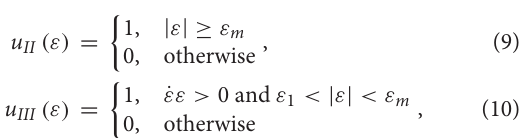
a (D) variation in c , (E) value of | ε | c for various values of c , (F) curve-fit of the response obtained with c ¯